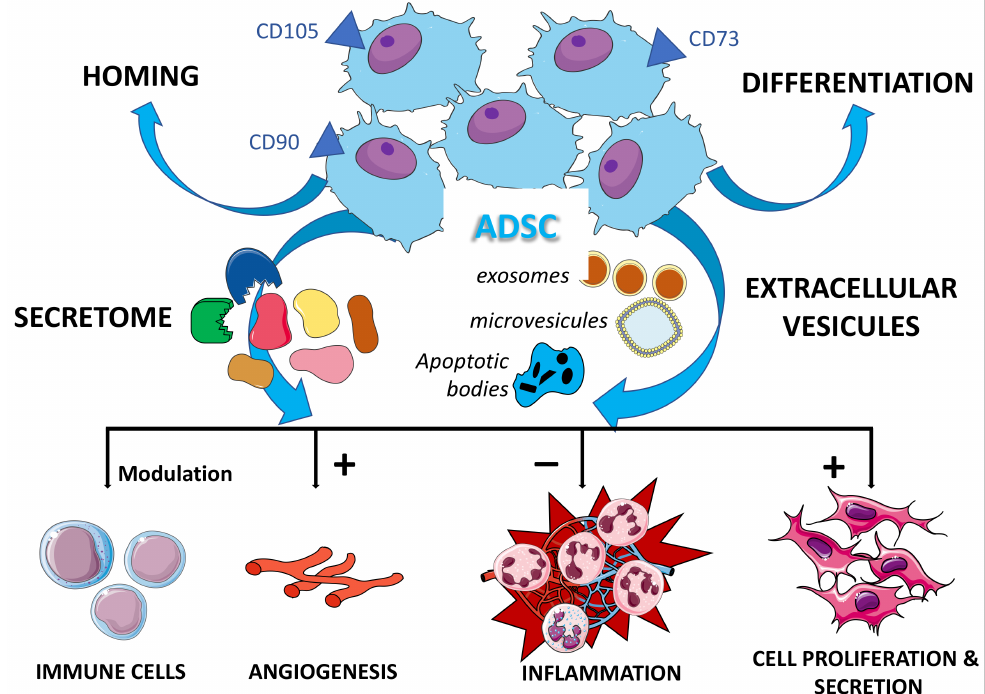
Figure 2. Main properties of adipose-derived stem cells (ADSC). (The secretome mainly contains interleukins, growth factors, indoleamine 2,3-dioxygenase, prostaglandin E2, NO, Lipoxin A4, Neurotrophin-3, etc.; the extracellular vesicles carry membrane and cytosolic proteins, transcription factors, DNA, mRNA, rRNA, miRNA and key molecules of various transduction signals . . .